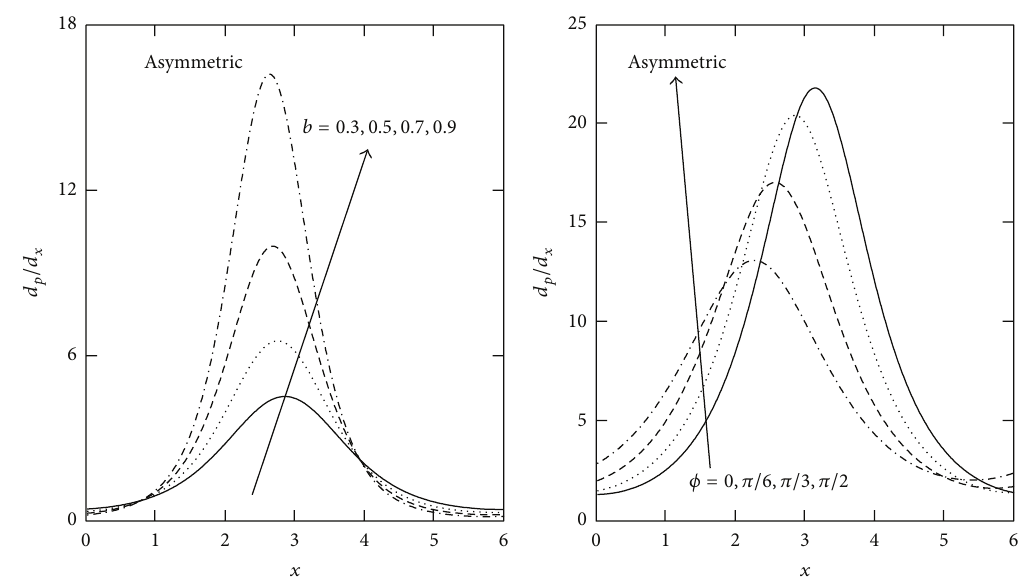
Figure 2: Variation of 𝑑𝑝/𝑑𝑥 with influence of 𝑏 and 𝜙 respect to 𝑥